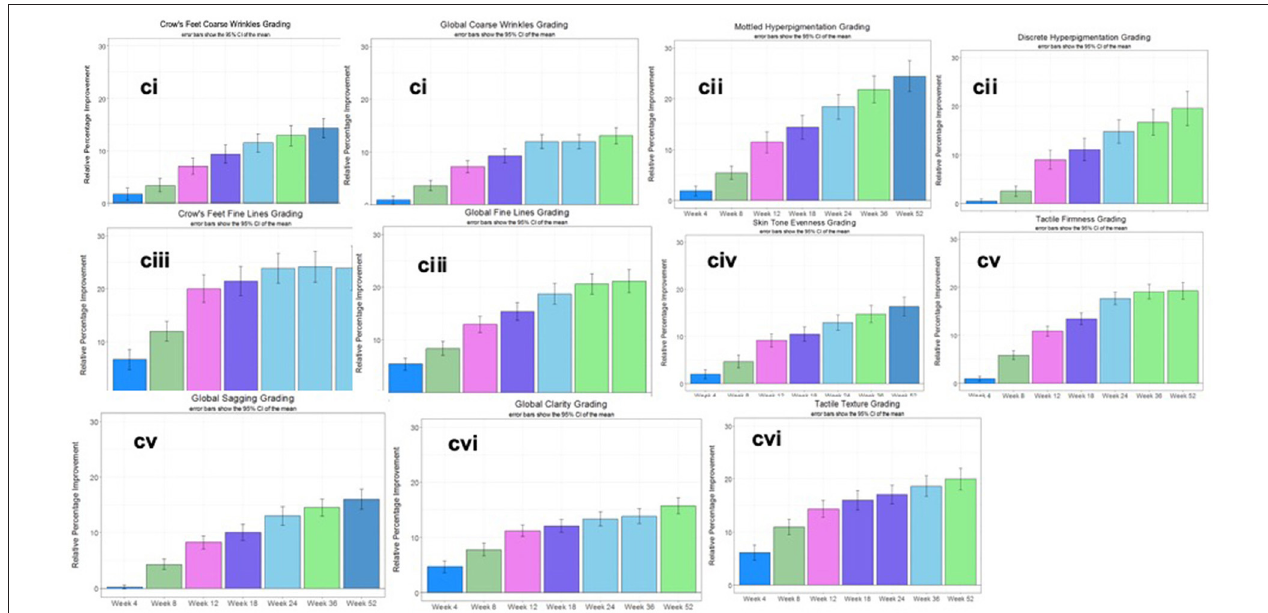
FIGURE 13 | Clinical trial #2 results. (Ci) Month-to-month significant improvement in dermatological grading up to 1 year. Dermatological grading shows statistically significant improvement ( p < 0.05) in global crow’s feet coarse wrinkle parameters. Bar color changes month-to-month indicates statistical improvement from previous timepoint. This pattern of improvements noted throughout the year are an indication the plateau effect can be overcome with this specific rotational formulation. (Cii) Month-to-month significant improvement in dermatological grading up to 1 year. Dermatological grading shows statistically significant improvement ( p < 0.05) in mottled and discrete hyperpigmentation parameters. Bar color changes month to month indicates statistical improvement from previous timepoint. This pattern of improvements noted throughout the year are an indication the plateau effect can be overcome with this specific rotational formulation. (Ciii) Month-to-month significant improvement in dermatological grading up to 1 year. Dermatological grading shows statistically significant improvement ( p < 0.05) in global fine and crow’s feet wrinkle parameters. Bar color changes month to month indicates statistical improvement from previous timepoint. This pattern of improvements noted throughout the year are an indication the plateau effect can be overcome with this specific rotational formulation. (Civ) Month-to-month significant improvement in dermatological grading up to 1 year. Dermatological grading shows statistically significant improvement ( p < 0.05) in skin tone evenness parameter. Bar color changes month to month indicates statistical improvement from previous timepoint. This pattern of improvements noted throughout the year are an indication the plateau effect can be overcome with this specific rotational formulation. (Cv) Month-to-month significant improvement in dermatological grading up to 1 year. Dermatological grading shows statistically significant improvement ( p < 0.05) in tactile firmness and global sagging parameters. Bar color changes month to month indicates statistical improvement from previous timepoint. This pattern of improvements noted throughout the year are an indication the plateau effect can be overcome with this specific